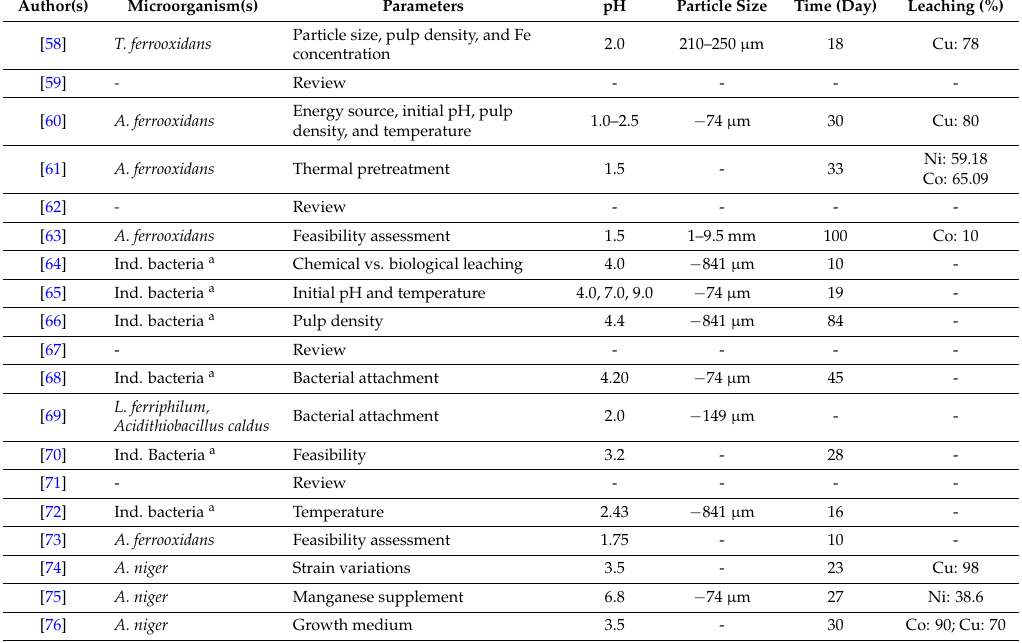
Table 4. Bioleaching research of mineral ores and metal concentrates research according to the parameters studied and recoveries achieved as well as microorganisms used in the studies. The articles appear in chronological